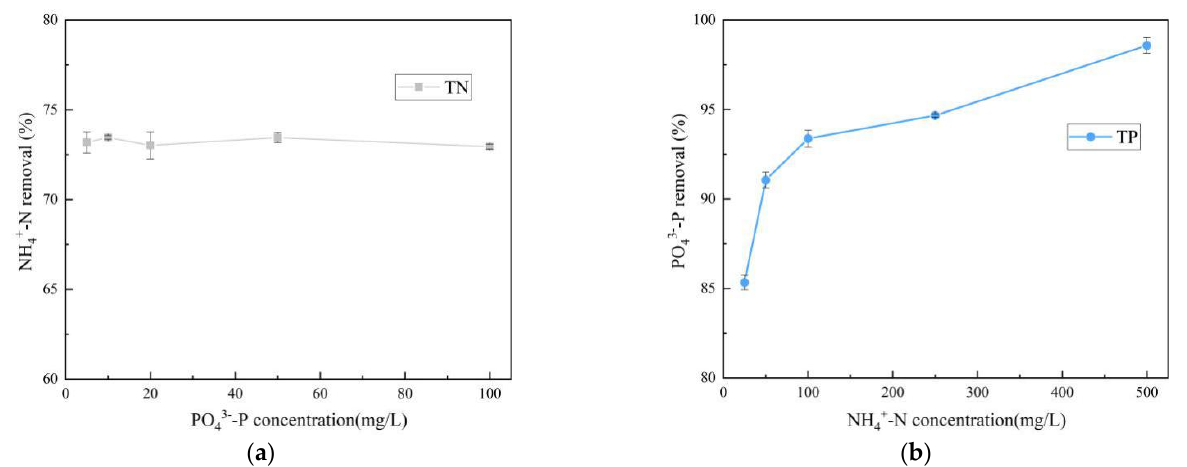
Figure 10. Effect of initial concentration of solution on simultaneous ammonium and phosphorus removal. ( a ) C N = 50 mg/L, C P = 5–100 mg/L; ( b ) C P = 10 mg/L, C N = 25–500 mg/L (pH = 8.0; T = 25 °C; adsorbent dosage = 4 g/L; t = 90 min). Three sets of parallel tests are taken, and the error results are expressed in the form of error bars.